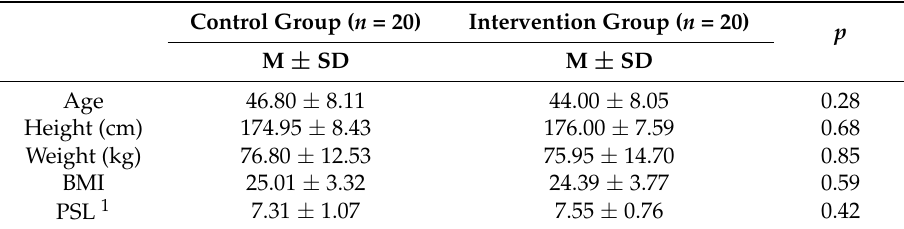
Table 1. Socio-demographic characteristics of study sample